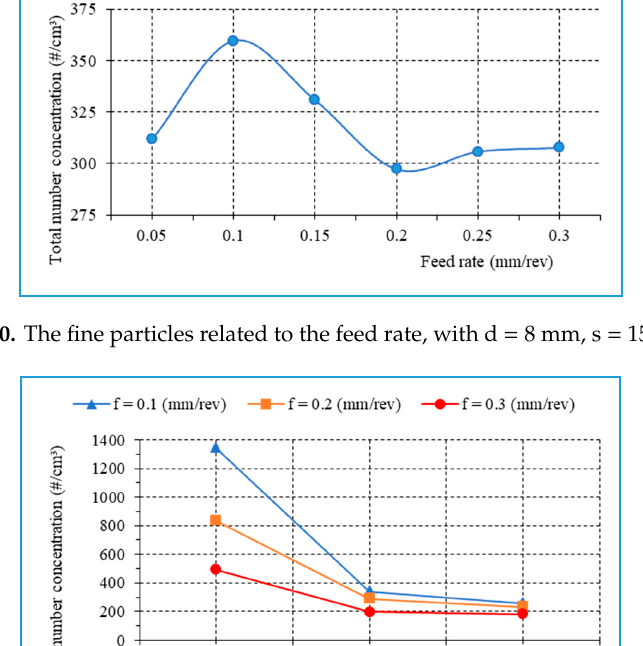
Figure 19. The number of fine particles versus the feed rate during drilling with different cutting parameters, d = 6 mm.